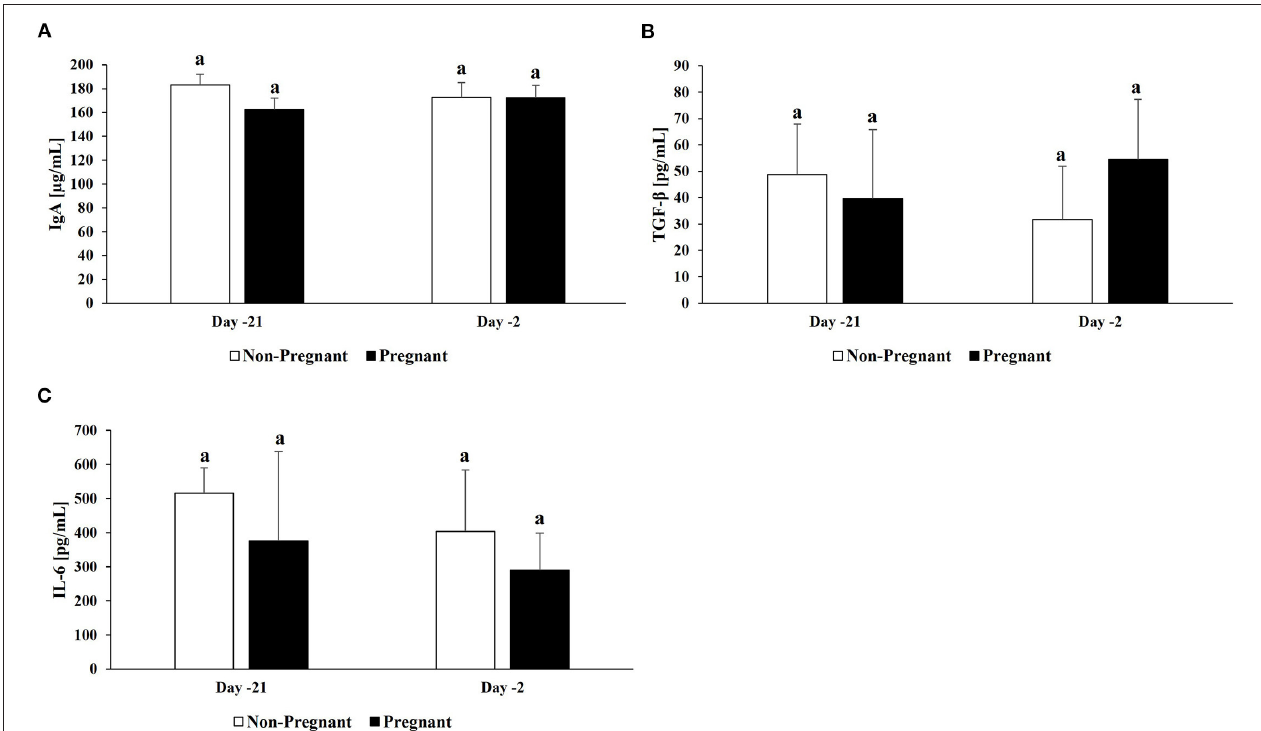
FIGURE 1 | Cytokine concentrations in vaginal samples. For a subset of cows ( n = 10; n = 5/group), cytokine concentrations were determined in vaginal samples: (A) IgA, (B) TGF- β , and (C) IL-6. Non-pregnant cows are indicated by white bars and pregnant cows by black bars for both d − 21 and − 2. Different superscripts denotes significant differences ( P ≤